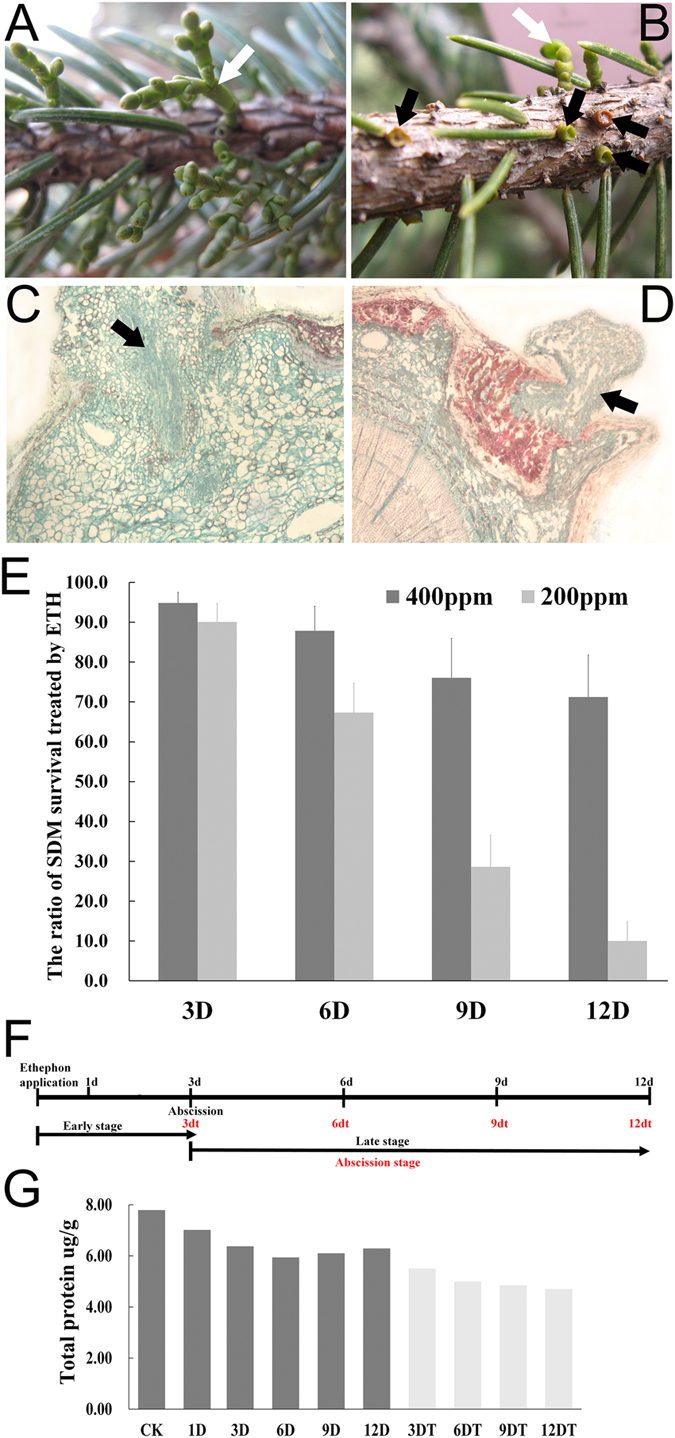
Effects of ethephon treatment on Arceuthobium.(A and B) The abscission of SDM shoots at 3 days after water (A) and ethephon (B) treatment. Black arrows represent abscission sites of SDM shoots and white arrow shows non-abscised DM shoots. (C and D) Longitudinal section of SDM shoots emerging from spruce braches. Black arrows represent SDM shoots colonizing in the spruce braches. Blue and red portion show the living and dead plant cells of SDM and spruce. (E) SDM survival after ethephon application at different concentrations (200 and 400 ppm) during time course. (F) Schematic representation of the experimental design. SDM shoots were treated with 200 ppm ethephon. Abscised and non-abscised DM shoots were collected at early (1 and 3 days), late (6, 9 and 12 days), and abscised stages (3dt-12dt in red). (G) Total protein levels were measured in SDM shoots during time course.